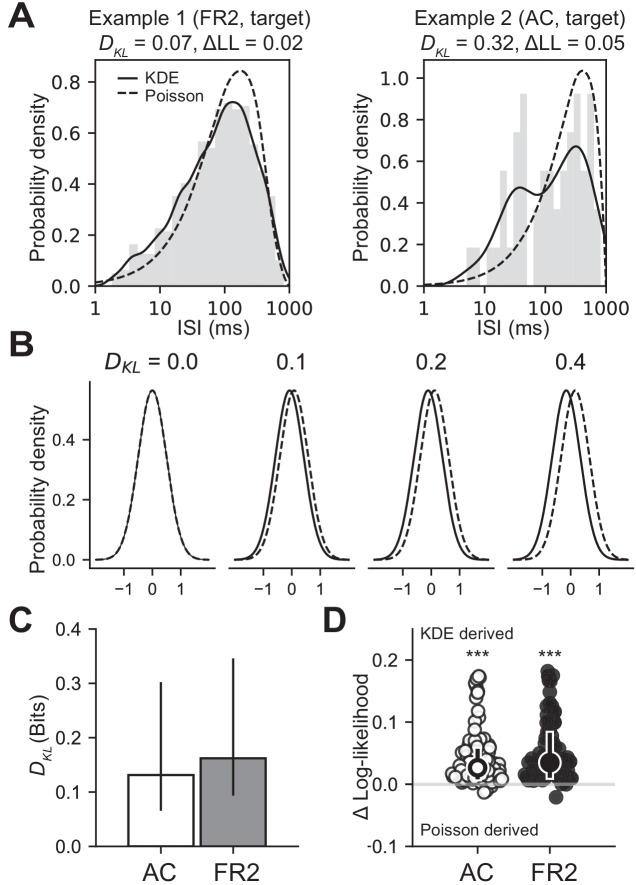
Empirical ISI distributions are better modeled using non-parametric methods.(A) ISI histograms from two example cells on target trials with the corresponding non-parametric Kernel Density Estimate (KDE) distribution (solid lines) and the distribution derived from a rate-modulated Poisson process (dashed lines). Above each example is the Kullback-Leibler divergence (DKL) quantifying the difference between these two distributions, and the difference in the average log-likelihood of the data (ΔLL) where positive values indicate that the data is better described by the non-parametric KDE distribution. (B) Constructed examples of the KL divergence for four pairs of normal distributions with equal standard deviations and various mean offsets as a visual reference (C) Summary of all KL divergence values for both stimulus and choice in AC (white) and FR2 (grey). Bar indicates median and error bars indicate bottom and top quartiles. (D) Summary of difference between log-likelihood of observed data under non-parametric KDE and rate-modulated Poisson distributions. Positive values indicate KDE distributions are generically a superior fit for the data (AC: p=1.1 × 10−15 FR2: p=1.2 × 10−16, Wilcoxon signed-rank test).